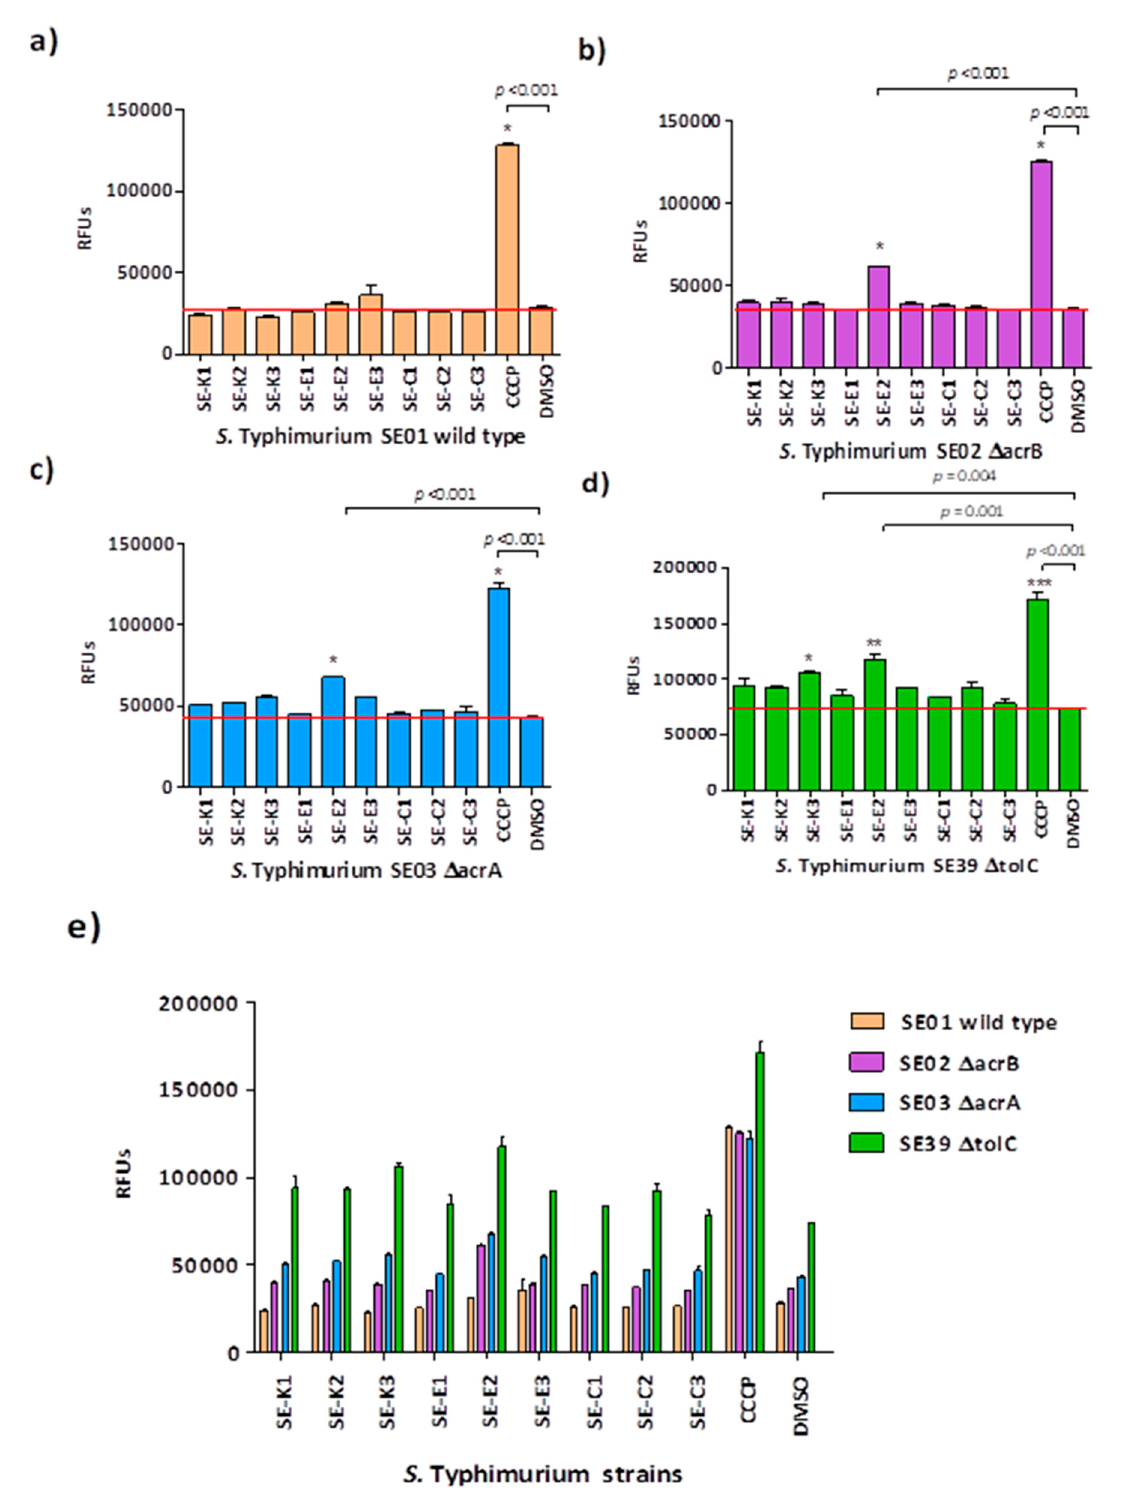
Figure 1. Ethidium bromide (EB) accumulation in S . Typhimurium strains in the presence of Se-compounds . The graphs show the relative fluorescence units (RFUs) of ( a ) S. Typhimurium SE01, ( b ) S. Typhimurium SE02, ( c ) S. Typhimurium SE03, ( d ) S. Typhimurium SE39, and ( e ) all S. Typhimurium bacterial strains in the presence of the compounds in the 60th minute of the assay. In case of S. Typhimurium SE01, -SE02 and -SE03 the level of significance was * p < 0.001. The levels of significance were * p = 0.004, ** p = 0.001, and *** p < 0.001 on S. Typhimurium SE39.